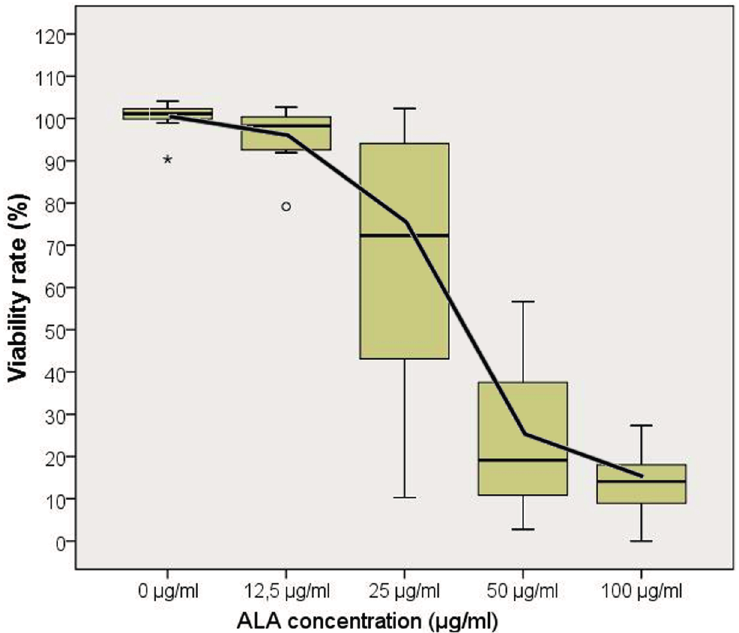
Figure 3. ALA-PDT showed an ALA dose-dependent decrease of cell viability as measured by WST-1 test. Note: the box plots show cell viability rate (%) after 5-ALA-PDT, as measured by WST-1 assay for different 5-ALA concentrations (median ± SD). The graph shows the means of 10 experiments with EMA positive cells. The LD 50 was found to lie between 25 and 50 µg/mL; note: outliers (>1 standard deviation) were marked by stars or circles.